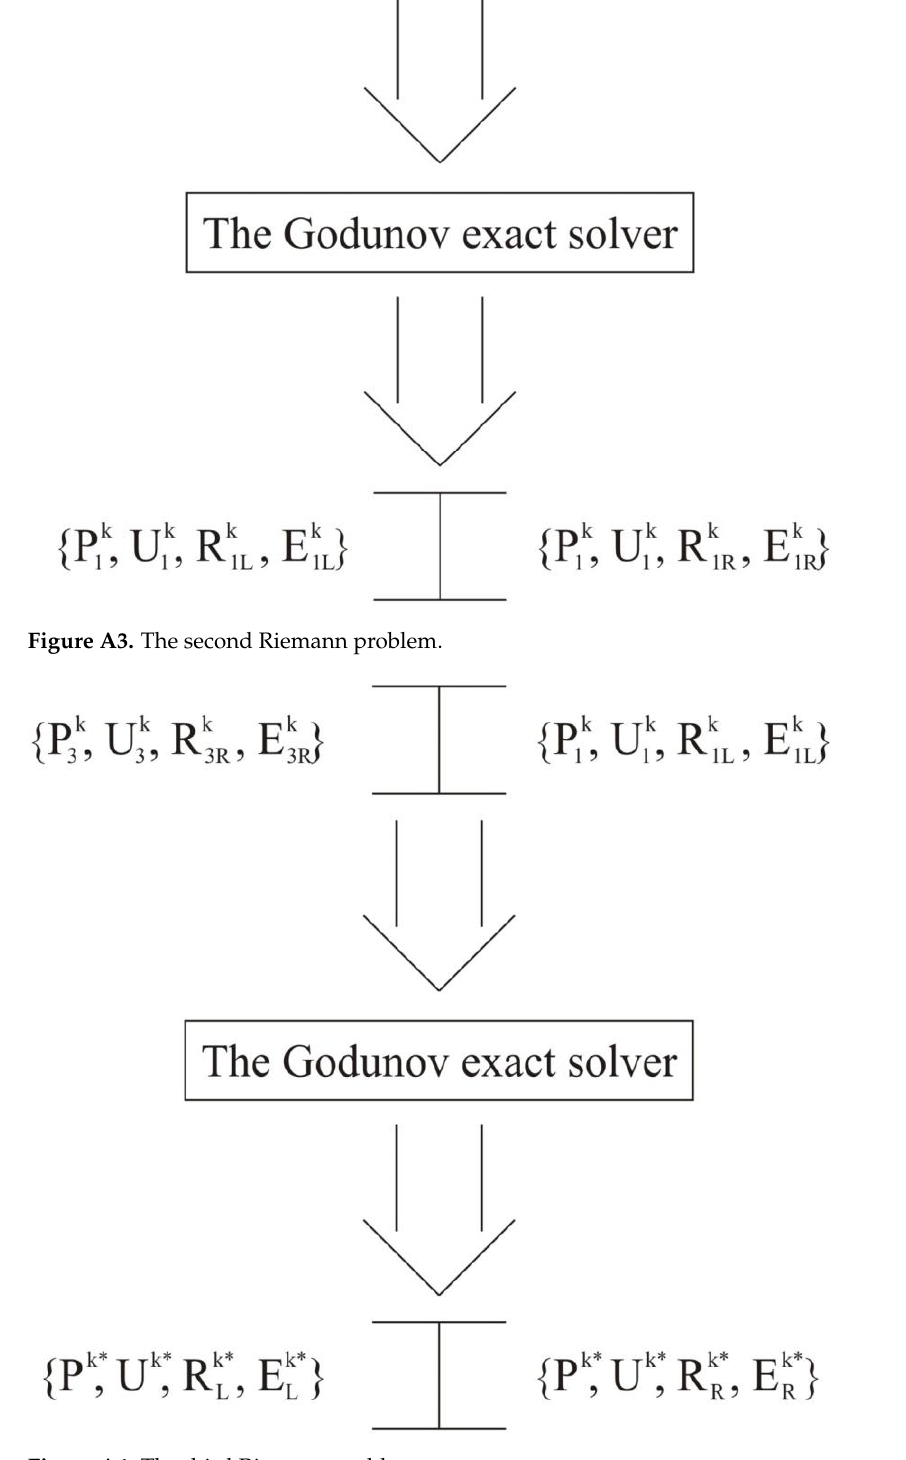
Figure A4. The third Riemann problem.